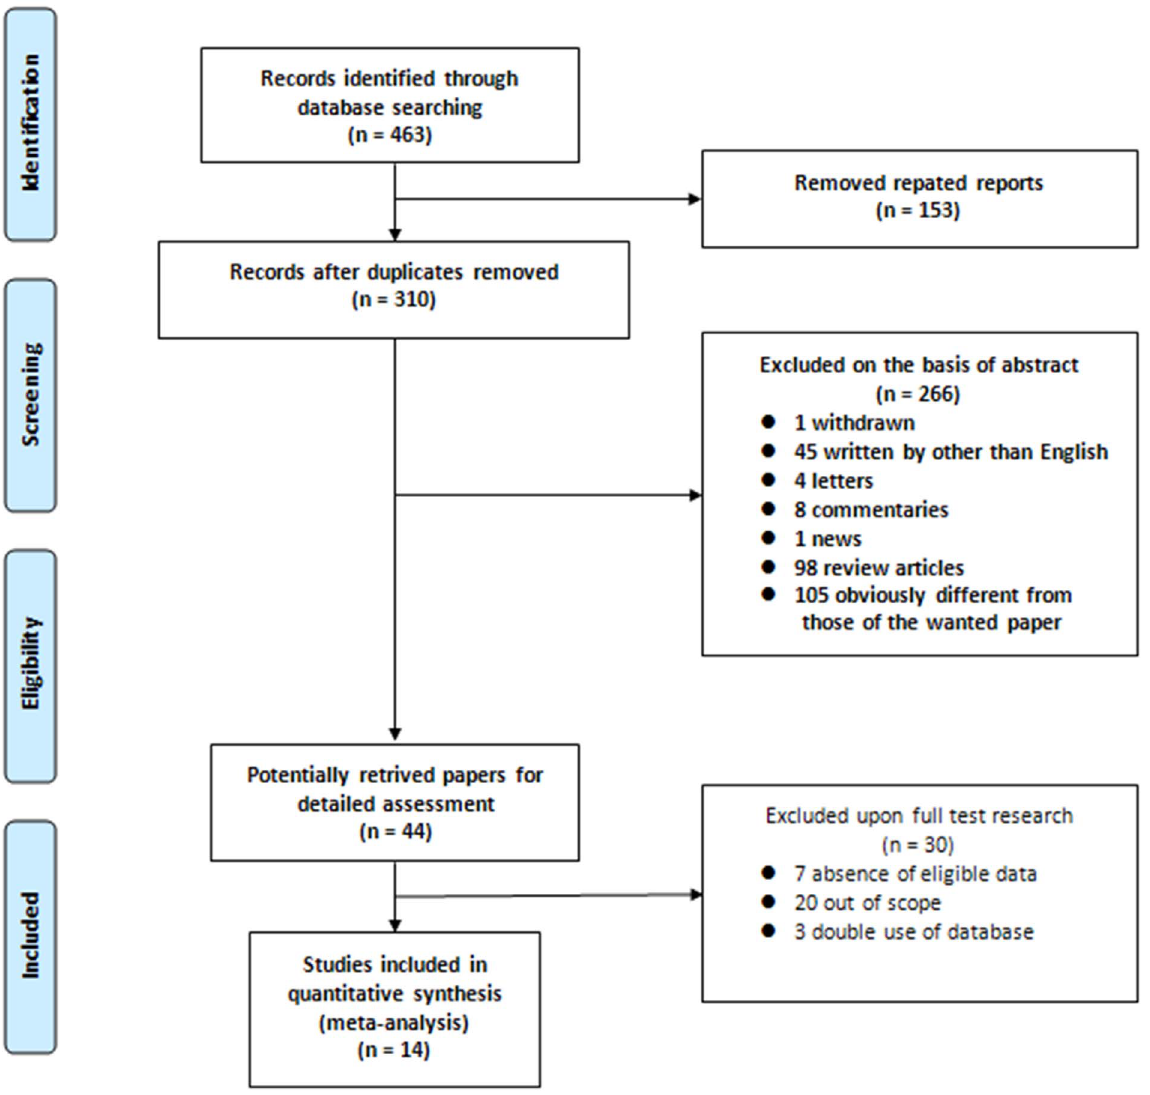
Figure 1. Methodological flow chart of the systematic review.